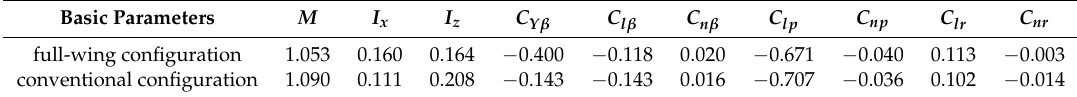
Table 1. The basic parameters of the full-wing and conventional